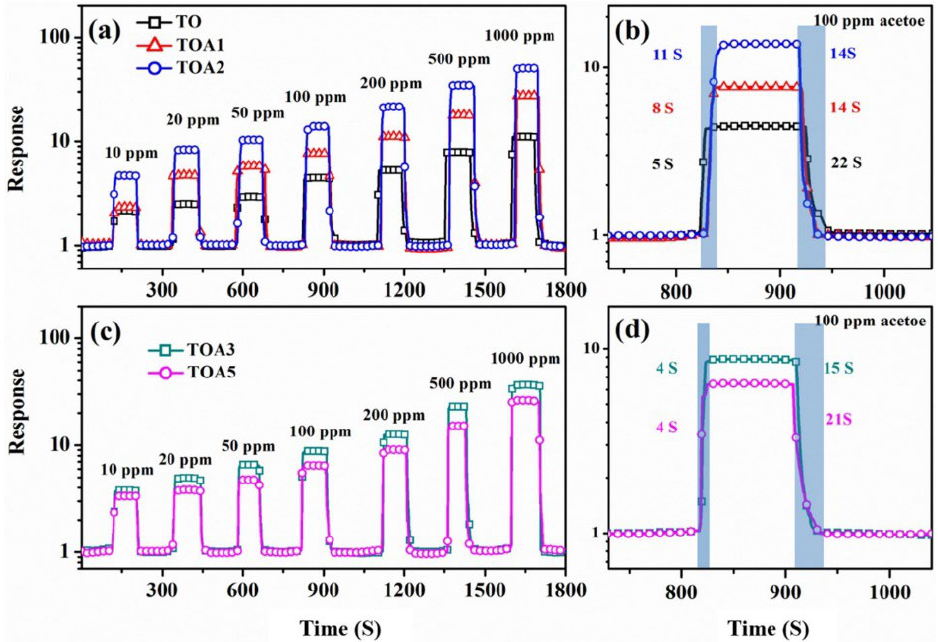
Figure 26. The dynamic response curves of sensors based on TO, TOA1, TOA2 ( a ), TOA3, and TOA5 ( c ) toward 10–1000 ppm acetone (TO at 315 ◦ C, whereas TOA1, TOA2, TOA3, and TOA5 at 275 ◦ C). The response and recovery times of TO, TOA1, TOA2 ( b ), TOA3, and TOA5 ( d ) are shown in the figure. Reprinted from [107].